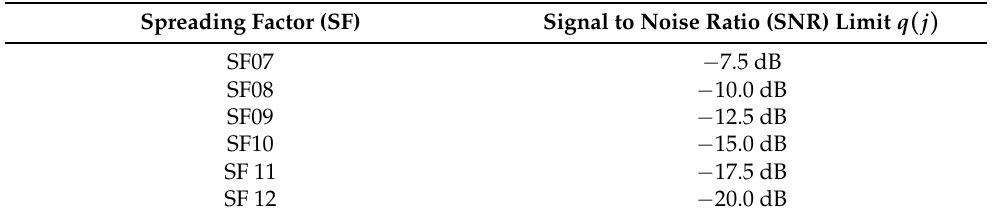
Table 4. Signal to noise ratio (SNR)